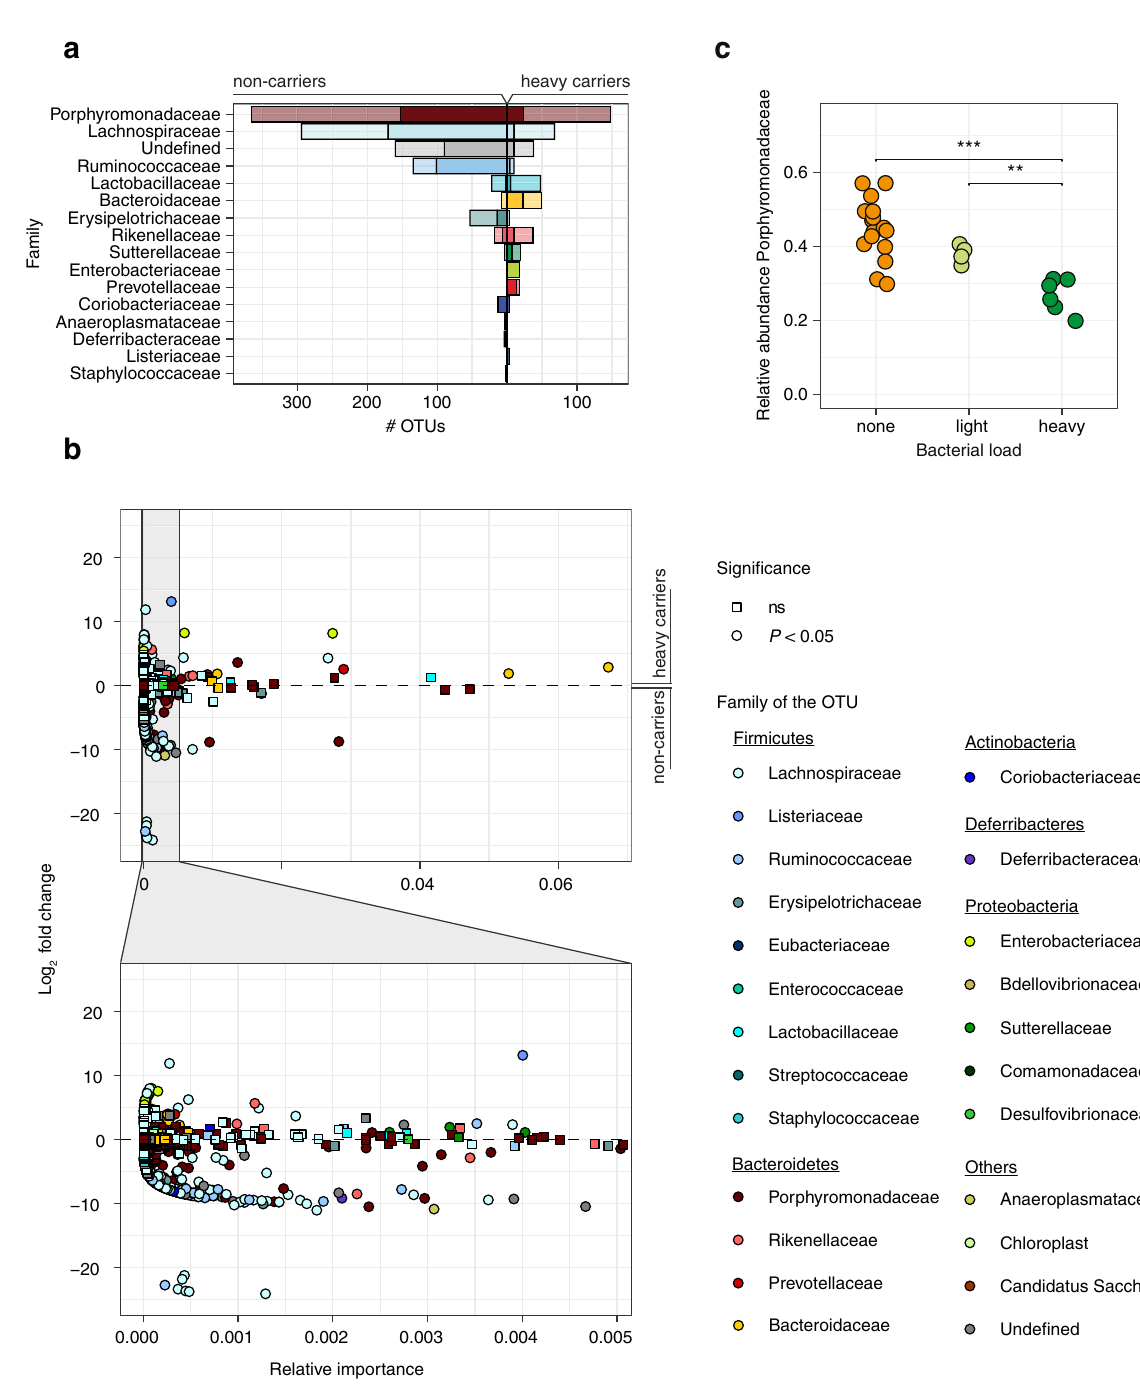
Fig. 7 Microbiota composition in mice differs according to Lm faecal carriage. a Count of all OTUs enriched in non-carriers (left) or heavy carriers (right) identi fi ed by DESeq2. Opaque bars represent signi fi cantly different OTUs (after Benjamini – Hochberg correction). b Mean abundance and fold change of all OTUs between carrier and noncarrier mice determined by DESeq2. Opaque points signi fi cantly differ between the two groups ( P after Benjamini – Hochberg correction). c Relative abundance of Porphyromonadaceae in 16S rRNA data from mice from different carriage groups ( n none = 16, n low = 4, n heavy = 6, none vs. heavy: P = 0.0001, light vs. heavy: P = 0.0095). The statistical comparison was performed with a two-sided Wilcoxon rank-sum test. ** P < 0.01, *** P < Note that no culture-based identi fi cation was applicable given that the eNat protocol conserves nucleic acid and is bactericidal within 30min (see manufacturer ’ s instructions for details). We sequenced the hly gene from clustal omega 76 . position 327 to 829 with the primers CAAAATAATGCAGACATCCAAG and CTTTAGTAACAGCTTTGCCG for a subset ( N = 10) of Lm positive samples to ensure the speci fi city of the hly PCR assay. Sequences from Sanger